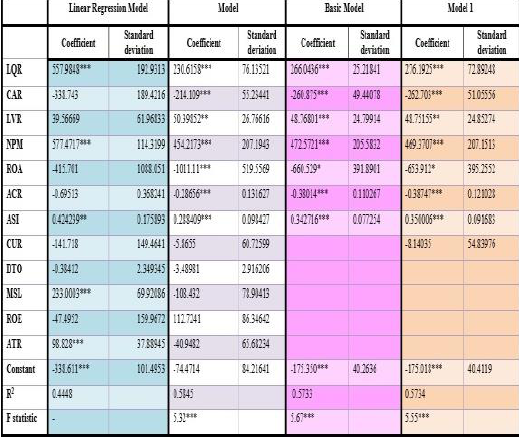
Table 9: Regression Models for Companies Traded in Other Countries’ Stock